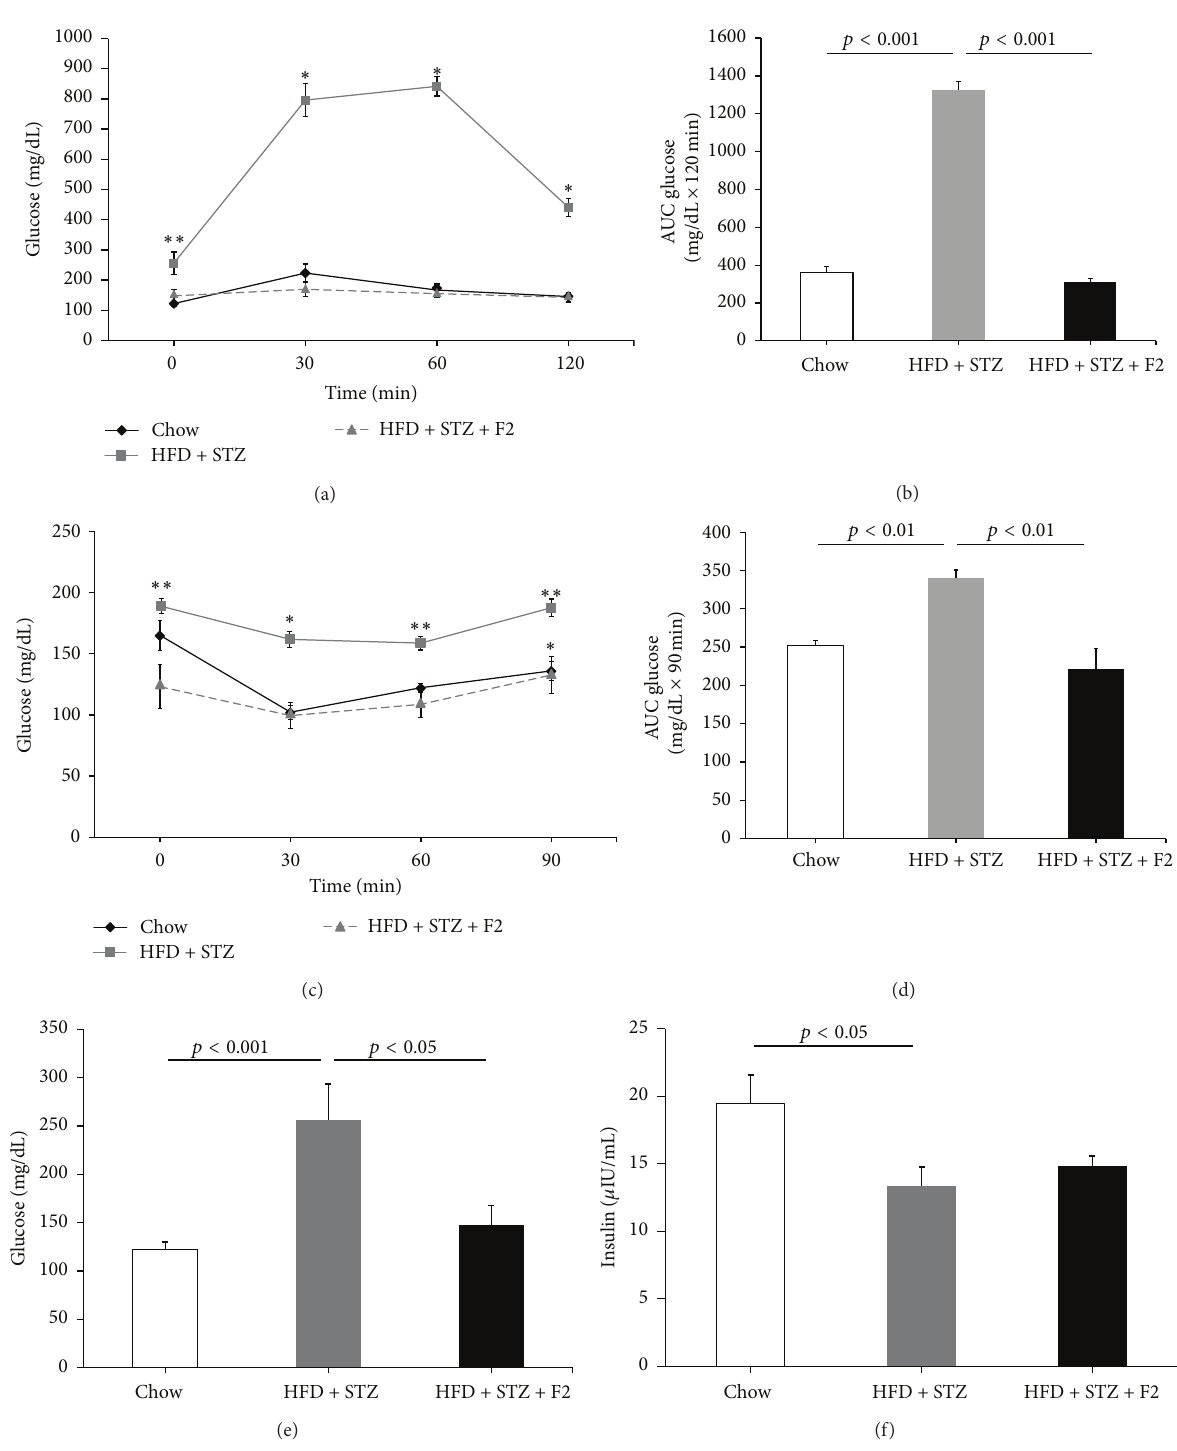
Figure 2: Glucose tolerance test (IPGTT) (a), insulin tolerance test (ITT) (c), fasting blood glucose levels (e), and fasting blood insulin levels (f) in F2 treated diabetic mice. All assays were performed after 10 IP treatment doses. ((b) and (d)) Area under the curve (AUC) values, calculated using data obtained in (a) and (c). HFD + STZ: diabetic control group and HFD + STZ + F2: diabetic group given 10 IP doses of ethyl acetate fraction (F2). ( 𝑛 = 6 .) ∗ 𝑝 < 0.05 and ∗∗ 𝑝 < 0.001 , Student t -test. Values are expressed as mean ±